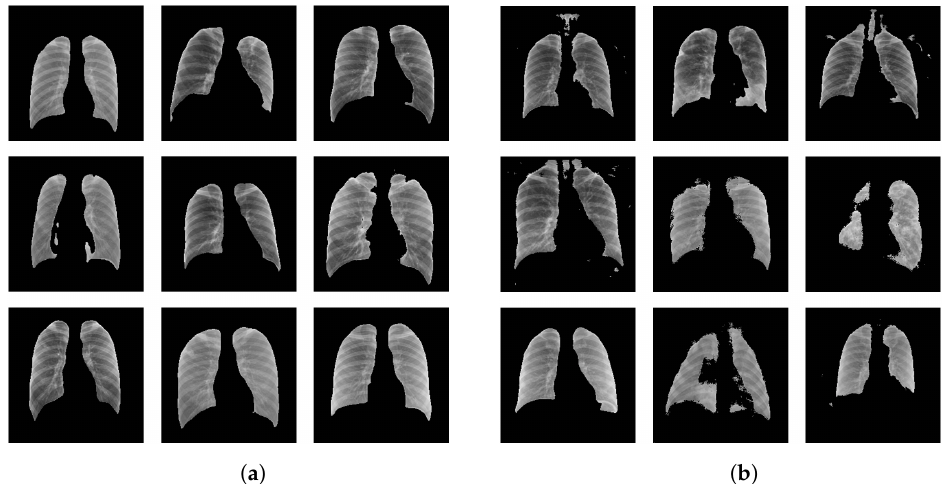
Figure 5. Example lung segmentations selected from the segmentations generated by the U-Net and DeepLabv3+ models with assigned labels: ( a ) labeled as ‘selected’ and ( b ) labeled as ‘not